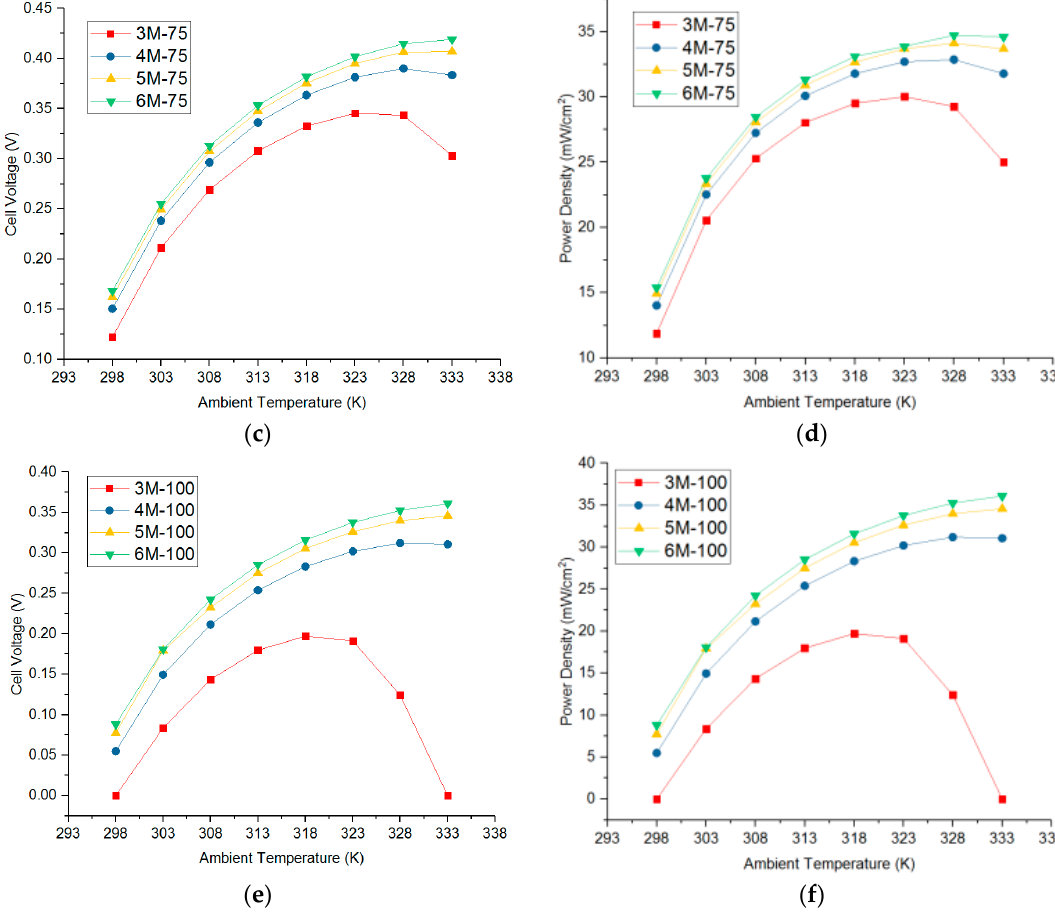
Figure 4. Relationship between output voltage (OV) and power density (PD) and ambient temperature (AT) under different current densities . ( a ) Relationship between AT and OV at 50 mA/cm 2 . ( b ) Relationship between AT and PD at 50 mA/cm 2 . ( c ) Relationship between AT and OV at 75 mA/cm 2 . ( d ) Relationship between AT and PD at 75 mA/cm 2 . ( e ) Relationship between AT and OV at 100 mA/cm 2 . ( f ) Relationship between AT and PD at 100 mA/cm 2 .